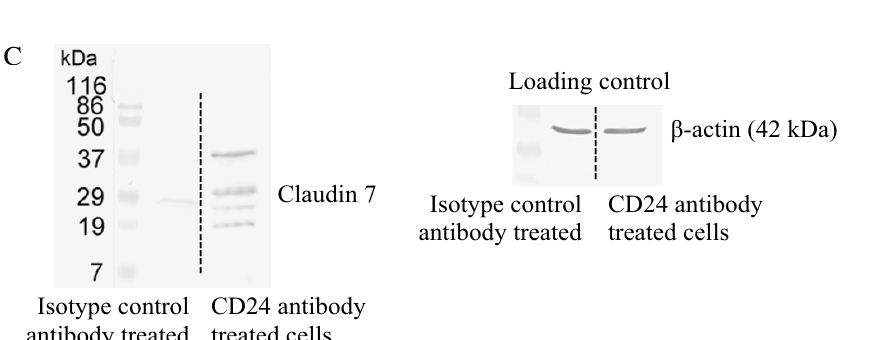
Figure 3 Western blot analysis for representative tight junction proteins extracted from H413 clone-1 cell monolayers . Data shown are representative of three independent experiments. Protein loading controls were confirmed by (cid:69) -actin stain. (A) Showing increased expression of tight junction proteins ZO-1 (210 kDa), ZO-2 (160 kDa) and occludin (65 kDa) in cul- tures treated with anti-CD24 peptide antibody compared to H413 monolayers treated with isotype IgG1 (5 (cid:80) g/ml) control antibody. (B) Bar graph confirmed increased expression of ZO-1, ZO-2 and occludin in anti-CD24 antibody treated sample compared to isotype control antibody by paired t-test (* Refers to P < 0.05). (C) Showing multiple bands in cultures treated with anti-CD24 peptide antibody for claudin-7 compared to H413 monolayers treated with isotype IgG1 (5 (cid:80) g/ml) control antibody (see explanation: Results and discussion). Specific bands were not detected for claudin-3 or par-6 in either isotype control or anti-CD24 antibody-challenged culture